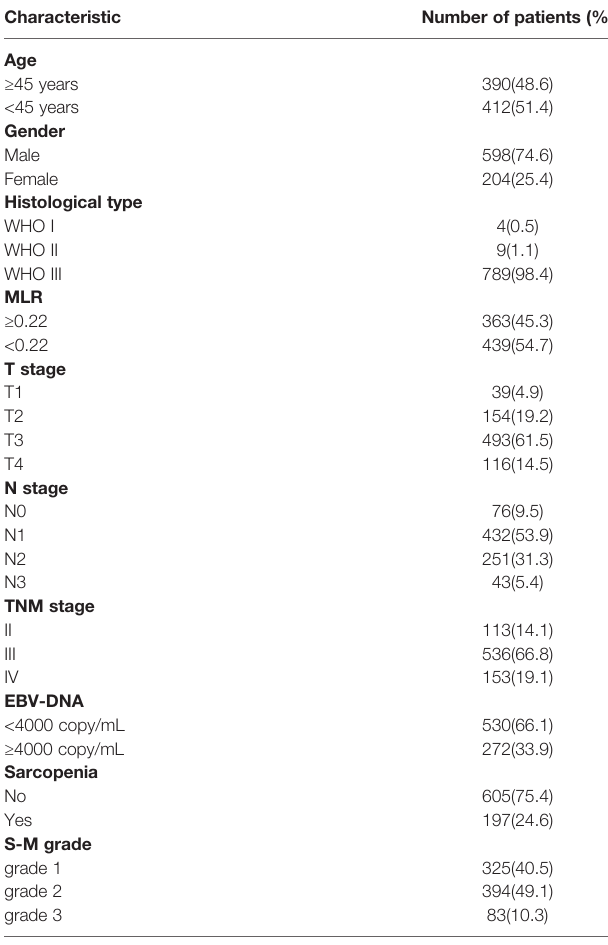
TABLE 1 | Patient demographics and clinical